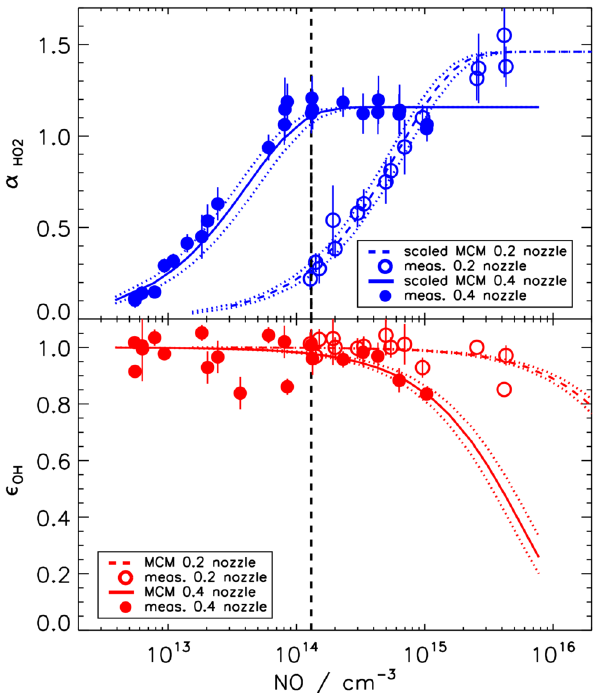
Fig. 3. Relative OH sensitivity (lower panel) and HO 2 (upper panel) conversion efficiency to OH depending on the NO concentration in the detection cell. Measurements (symbols) are compared to cal- culations using MCMv3.1 (lines). Two inlet nozzles with different orifices (0.2 and 0.4mm) were used, in order to vary the reaction time for the conversion in the cell (0.18 and 2.7ms). Dotted lines give results from sensitivity runs of the model varying the reaction time by ± 0.025 and ± 0.5ms, respectively. The vertical dashed line indicates the working point for the instrument with the 0.4mm noz- zle in the past.